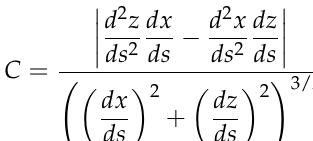
Figure 2. The free ‐ end deflection of the beam during laser heating, measured in experiments and calculated in numerical simulations, for various values of the loading force F. calculated in numerical simulations, for various values of the loading force F